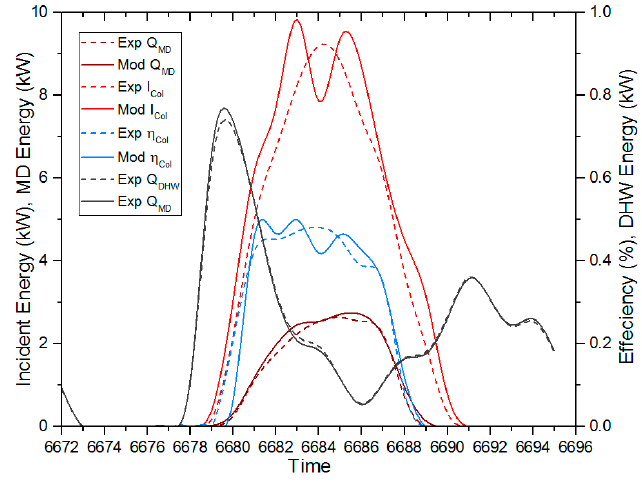
Figure 19. Incident radiation, energy flows and efficiency of SCMD.